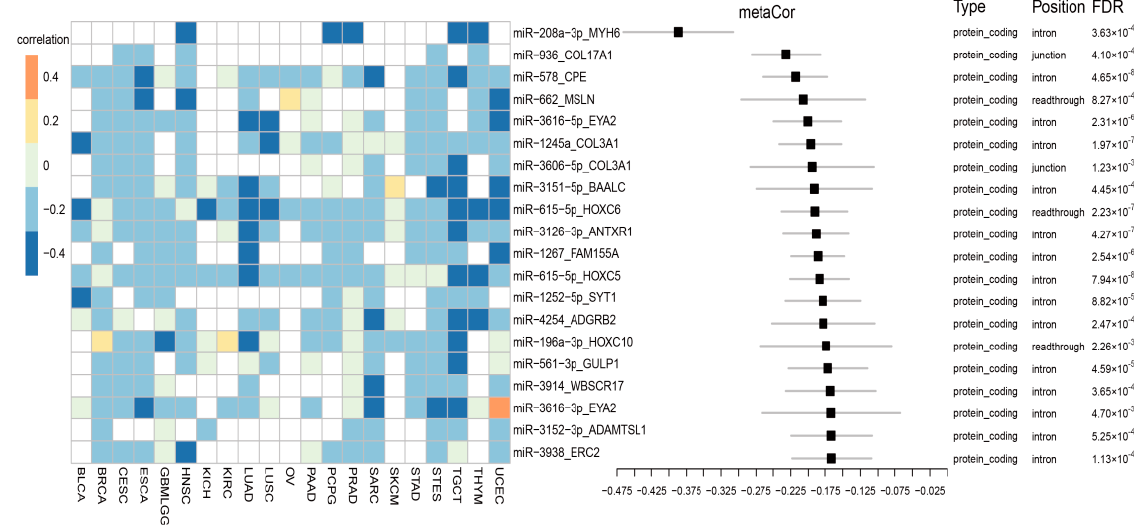
Figure 2. The top 20 negatively coexpressed miRNA-host pairs from a meta-analysis result of all cancers.